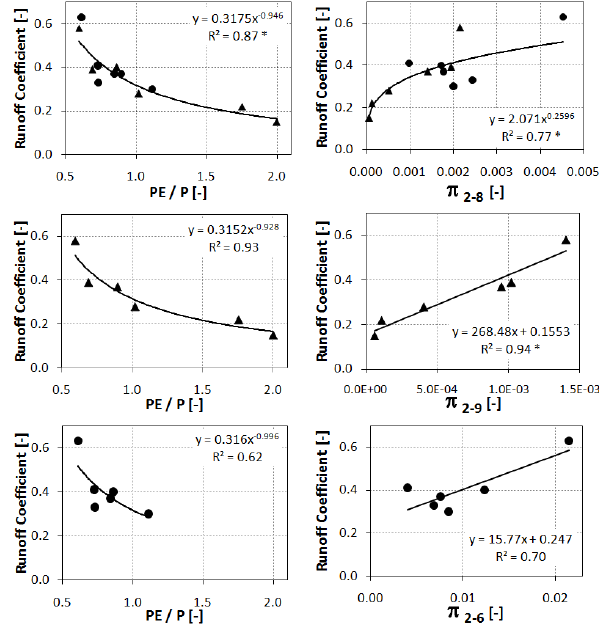
Figure 10 : Significant linear and non-linear regression relations between the runoff coefficient and different dimensionless numbers: Left: aridity index; Right: three dimensionless numbers Fig. 10. Significant linear and non-linear regression relations be- Figure 9 : Linear and non-linear regression relationships, significant at p<0.05 (* indicates related to different time scales in the models (2: canopy emptying; 6: root zone emptying by p<0.01), between hydrologic signatures and model time scales. Triangles indicate no snow drainage; 8: transmission zone filling; 9: transmission zone emptying). Triangles indicate no-snow tween the runoff coefficient and different dimensionless numbers: Fig. 9. Linear and non-linear regression relationships, significant at catchments and dots represent snow catchments. catchments and dots represent snow catchments. left panel: aridity index; right panel: three dimensionless numbers p < 0.05 ( ∗ indicates p < 0.01), between hydrologic signatures and related to different time scales in the models (2: canopy emptying; model time scales. Triangles indicate no snow catchments and dots 6: root zone emptying by drainage; 8: transmission zone filling; represent snow catchments. 9: transmission zone emptying). Triangles indicate no-snow catch- ments and dots represent snow